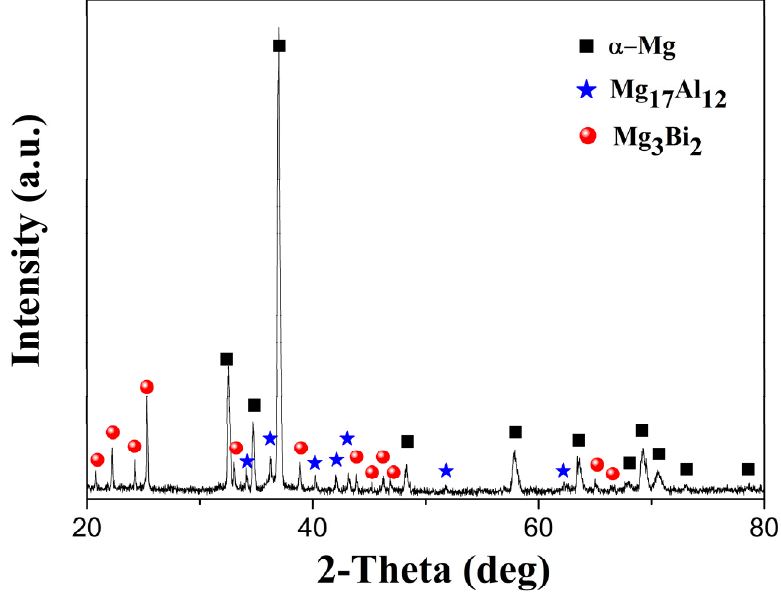
Figure 4. X-ray di ff raction (XRD) pattern of caliber-rolled AB83 Figure 4. X-ray diffraction (XRD) pattern of caliber-rolled AB83 alloy. Figure 4. X-ray diffraction (XRD) pattern of caliber-rolled AB83 alloy.